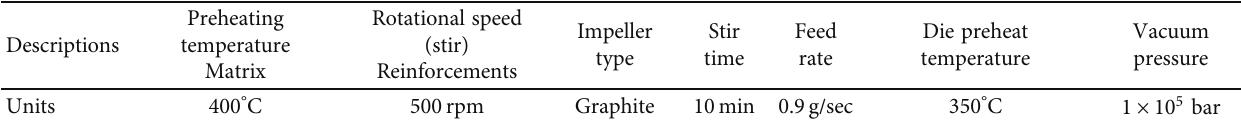
Figure 1: Actual fabrication setup for silver matrix composite. (a) Actual setup. (b) Processing chain with di ff erent thermal phase. (c) Pin on disc wear apparatus. Table 4: Process parameter for silver matrix